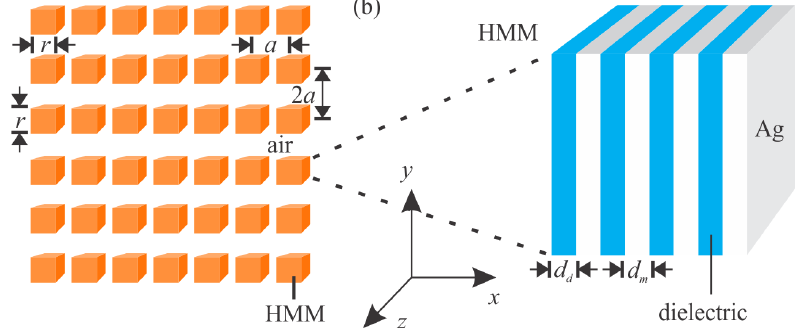
Figure 1. ( a ) Schematic of PhC membranes containing HMM square rods. ( b ) Schematic of HMMs composed of dielectric layers and Ag layers.